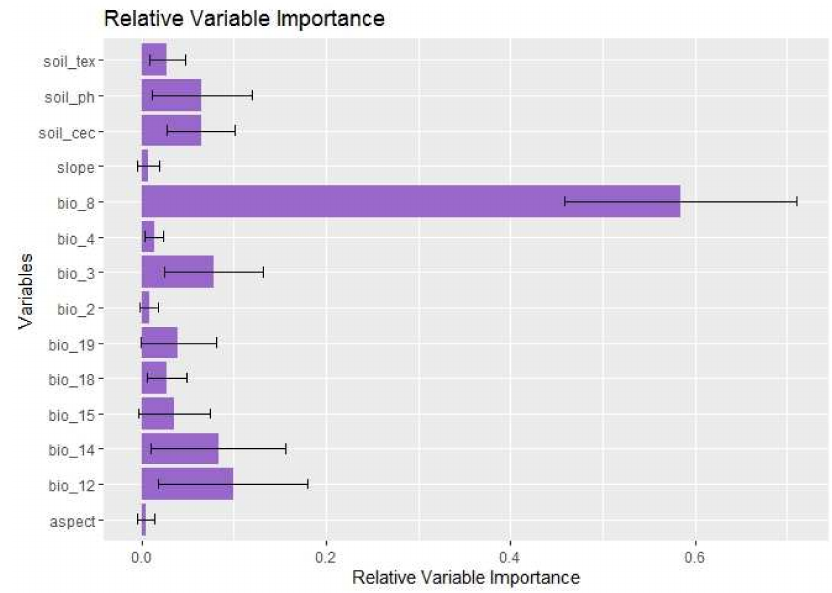
Figure 2. Relative contributions of environmental variables based on the ensemble modeling of the distribution of highland